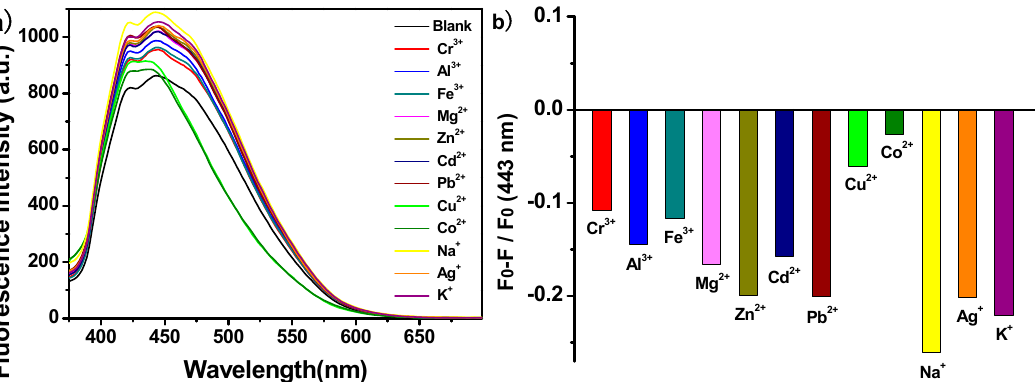
Figure 10. ( a ) Fluorescence spectra of PBT (50 μ g L − 1 ) in the absence (blank) and presence of different metal salts (1.0 × 10 − 5 mol L − 1 ) recorded in an NMP/H 2 O (9:1, v / v ) solvent system at pH 7.0, excitation wavelength is 350 nm; ( b ) fluorescence intensity change plot for PBT where ( F 0 − F )/ F 0 is plotted against each metal ion ( F 0 is the fluorescence intensity in the absence of metal ions, and F is the intensity when metal ions are present).